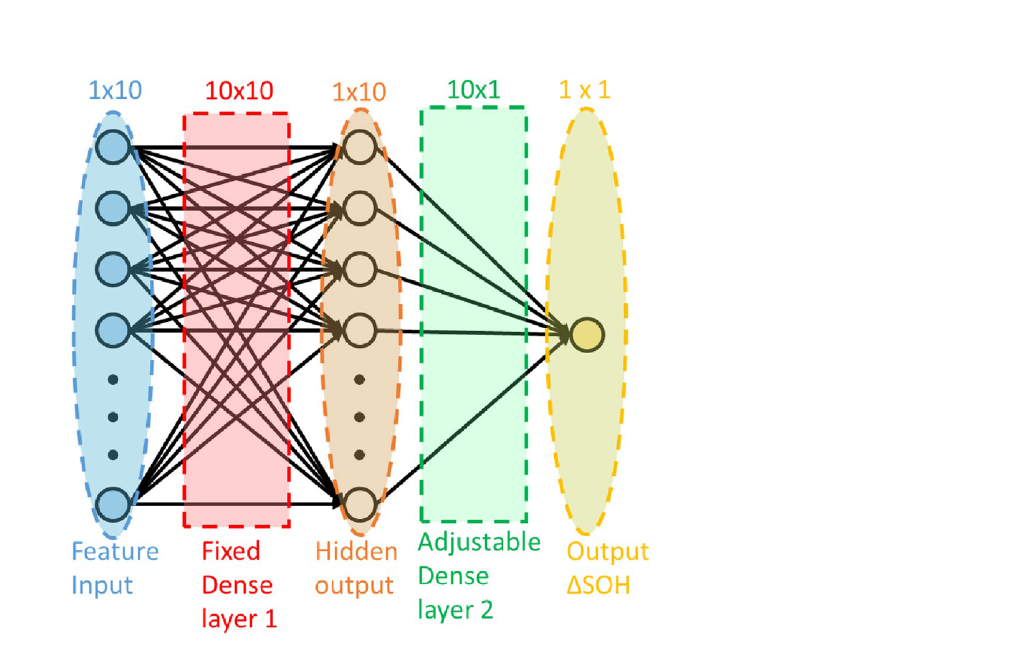
Figure 9. The two layer ANN used for mapping (cid:31) V r to (cid:31) SOH